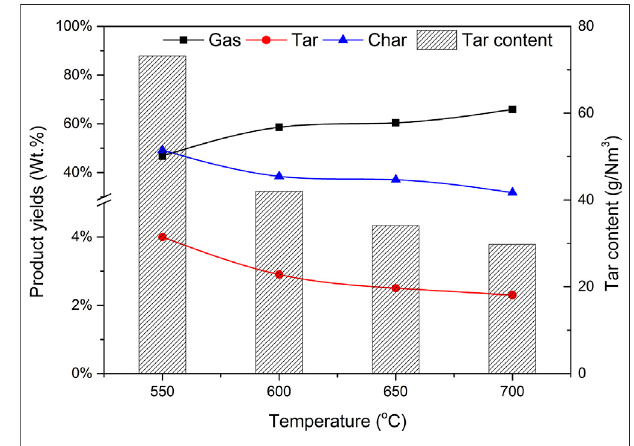
FIGURE 8 | Effect of CBR on product yields and tar content.